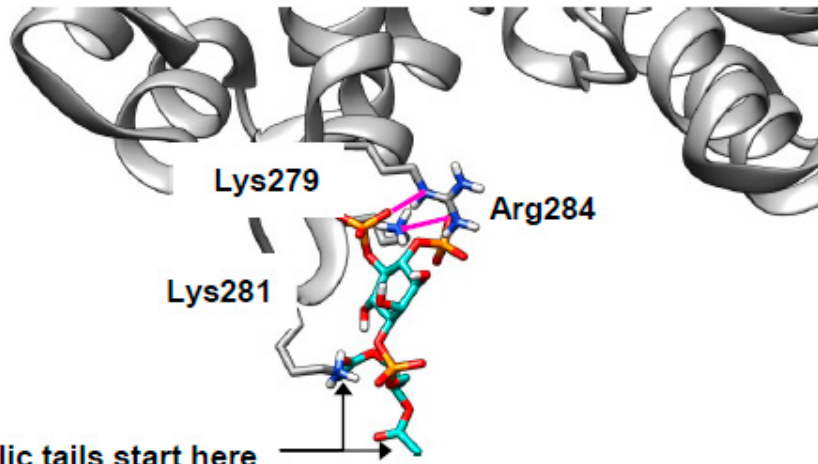
Figure 6. PI(4,5)P 2 can bind to annexin A2 (AnxA2). PI(4,5)P 2 (turquoise) can bind to the convex face of AnxA2 (grey) driven by zwitterionic interactions (magenta) with Lys279, Lys281, and Arg284.